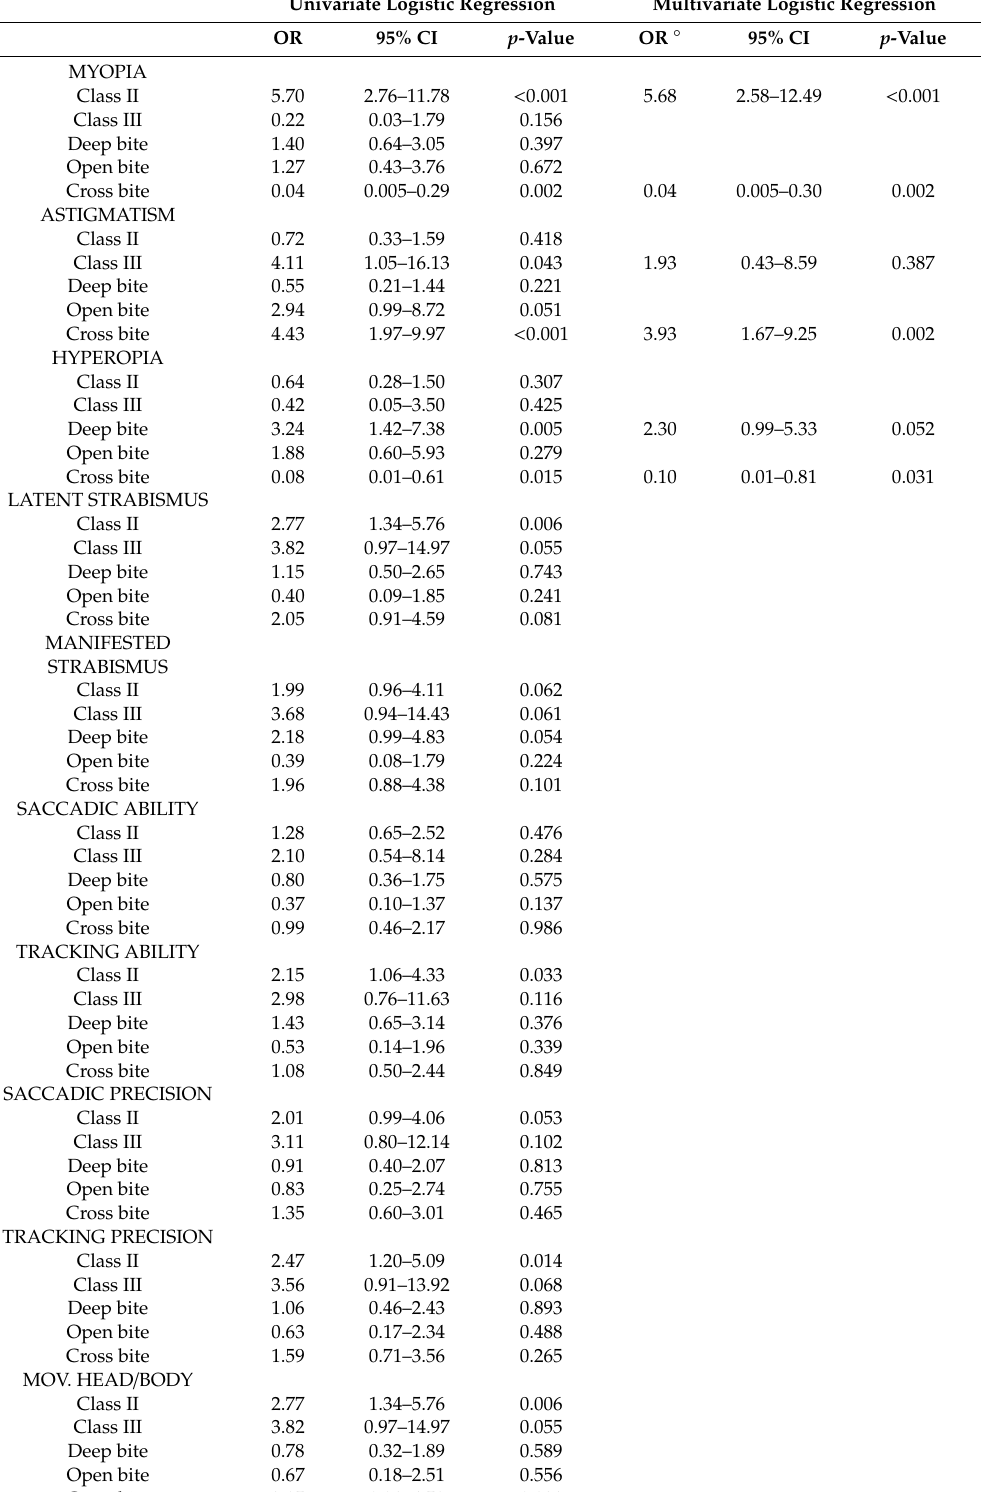
Table 2. Univariate and multivariate logistic regression analysis for the association between vision defects and orthodontic